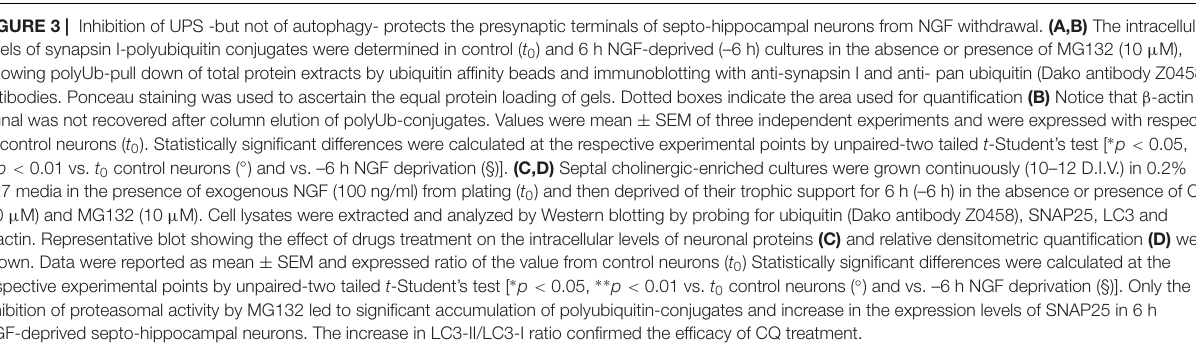
FIGURE 3 | Inhibition of UPS -but not of autophagy- protects the presynaptic terminals of septo-hippocampal neurons from NGF withdrawal. (A,B) The intracellular levels of synapsin I-polyubiquitin conjugates were determined in control ( t 0 ) and 6 h NGF-deprived (–6 h) cultures in the absence or presence of MG132 (10 µ M), following polyUb-pull down of total protein extracts by ubiquitin affinity beads and immunoblotting with anti-synapsin I and anti- pan ubiquitin (Dako antibody Z0458) antibodies. Ponceau staining was used to ascertain the equal protein loading of gels. Dotted boxes indicate the area used for quantification (B) Notice that β -actin signal was not recovered after column elution of polyUb-conjugates. Values were mean ± SEM of three independent experiments and were expressed with respect to control neurons ( t 0 ). Statistically significant differences were calculated at the respective experimental points by unpaired-two tailed t -Student’s test [ ∗ p < 0.05, ∗∗ p < 0.01 vs. t ◦ ) and vs. –6 h NGF deprivation (§)]. (C,D) Septal cholinergic-enriched cultures were grown continuously (10–12 D.I.V.) in 0.2% B27 media in the presence of exogenous NGF (100 ng/ml) from plating ( t 0 ) and then deprived of their trophic support for 6 h (–6 h) in the absence or presence of CQ (10 µ M) and MG132 (10 µ M). Cell lysates were extracted and analyzed by Western blotting by probing for ubiquitin (Dako antibody Z0458), SNAP25, LC3 and β -actin. Representative blot showing the effect of drugs treatment on the intracellular levels of neuronal proteins (C) and relative densitometric quantification (D) were shown. Data were reported as mean ± SEM and expressed ratio of the value from control neurons ( t 0 ) Statistically significant differences were calculated at the respective experimental points by unpaired-two tailed t -Student’s test [ ∗ p < 0.05, ∗∗ p < 0.01 vs. t 0 control neurons ( ◦ ) and vs. –6 h NGF deprivation (§)]. Only the inhibition of proteasomal activity by MG132 led to significant accumulation of polyubiquitin-conjugates and increase in the expression levels of SNAP25 in 6 h NGF-deprived septo-hippocampal neurons. The increase in LC3-II/LC3-I ratio confirmed the efficacy of CQ